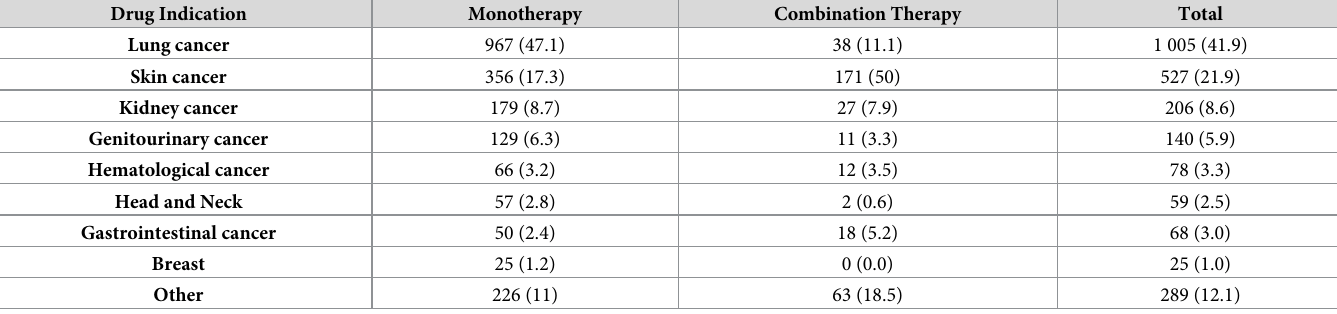
Table 2. Number of cardiac events associated with immune checkpoint inhibitor monotherapy or combination therapy by indication (total n = 2 631, reporting n (%)). Drug